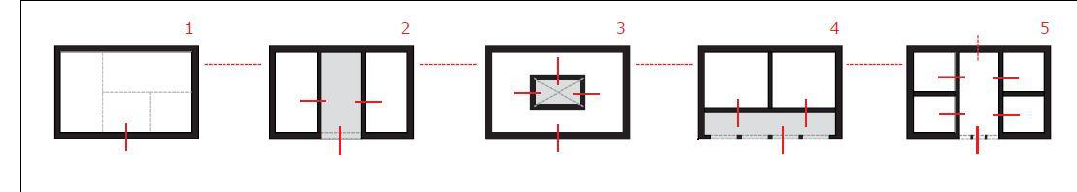
Figure 2. Outline of Syrian residential